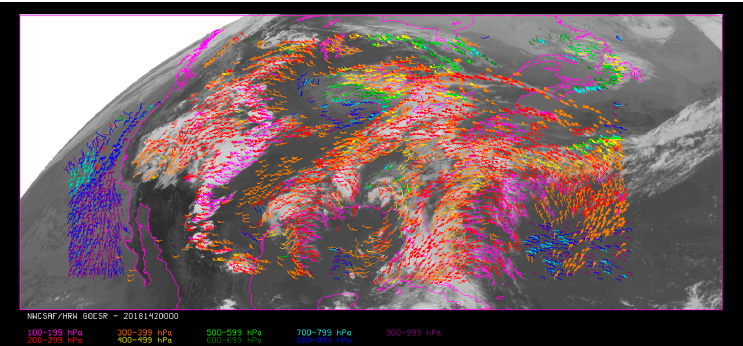
Figure 16. NWC/GEO-HRW v2018.1 AMV output example in the continental United States region considering the default conditions for processing (22 May 2018, 00:00 UTC, GOES-16 satellite, mode 3 scanning). Color coding based on the AMV pressure. Table 7. Validation for NWC/GEO-HRW v2018.1 AMVs against radiosonde winds, considering all AMVs together and in three separate layers: high levels: 100–400 hPa; medium levels: 400–700 hPa; low levels: 700–1000 hPa (Mar 2018–Aug 2018, 00:00/12:00 UTC, GOES-16 satellite, continental United States region).